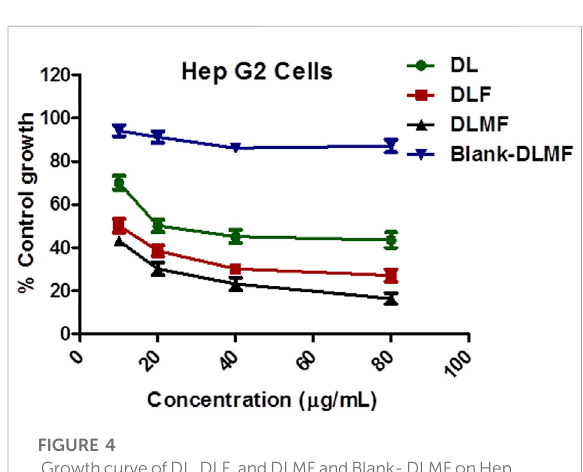
FIGURE 4 GrowthcurveofDL,DLF,andDLMFandBlank-DLMFonHep G2